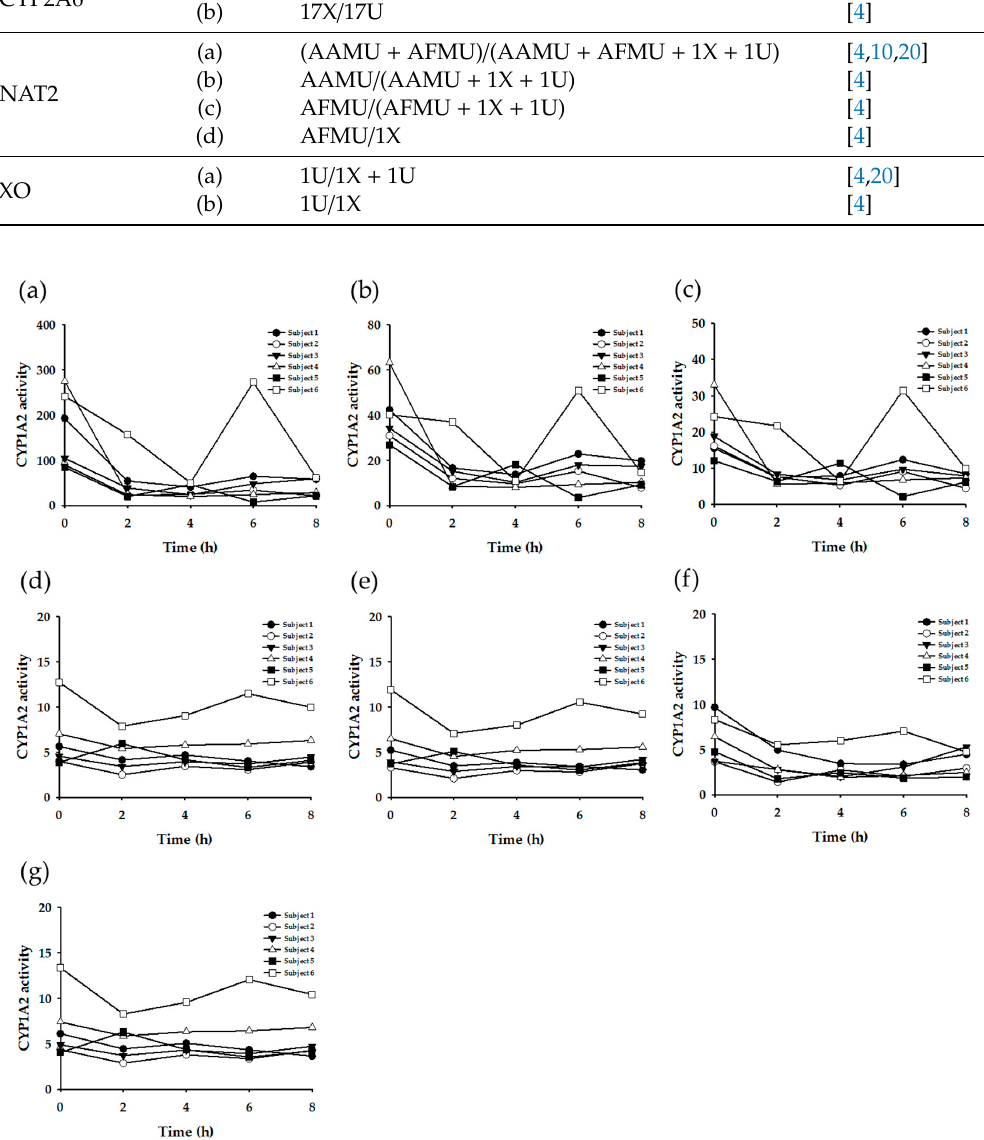
Figure 3. Plots of metabolite ratio for CYP1A2. The metabolic ratio equations used are as follows: ( a )